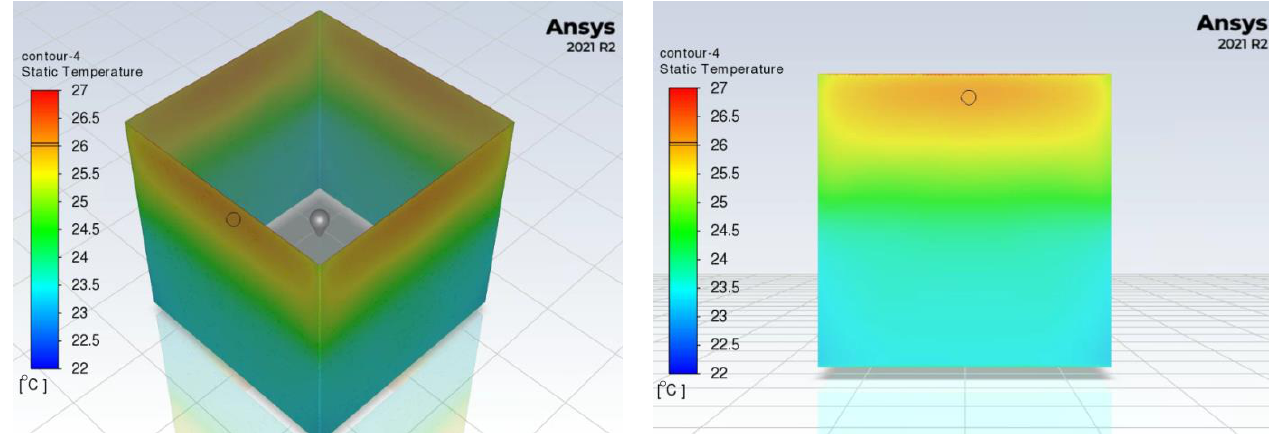
° ° Figure 8. Temperature distribution on the outer surface of the side walls, [°C]. Figure 8. Temperature distribution on the outer surface of the side walls, [ ◦